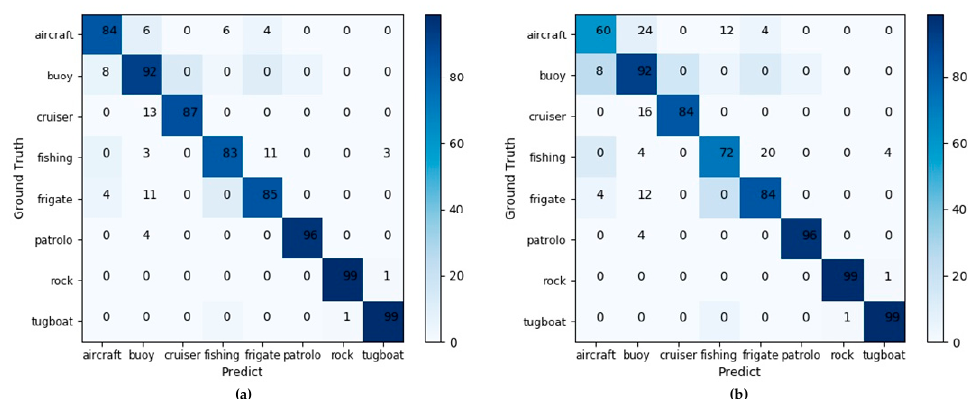
Figure 10. Confusion matrixes of different models: ( a ) our proposed model; ( b ) MAMC.